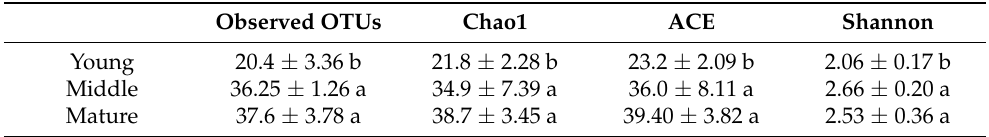
Table 1. Soil AM fungal diversity in different C. lanceolata plantations.